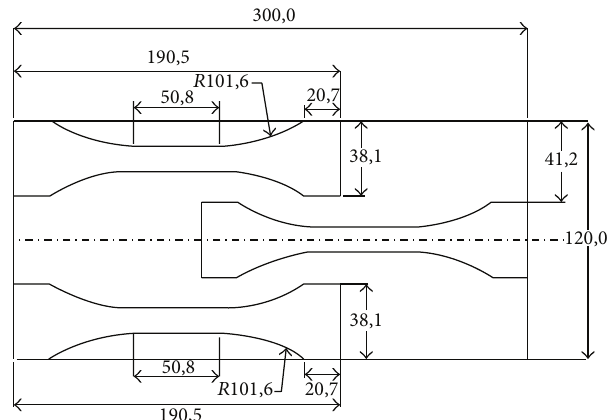
Figure 1: Tensile specimen, all the dimensions in